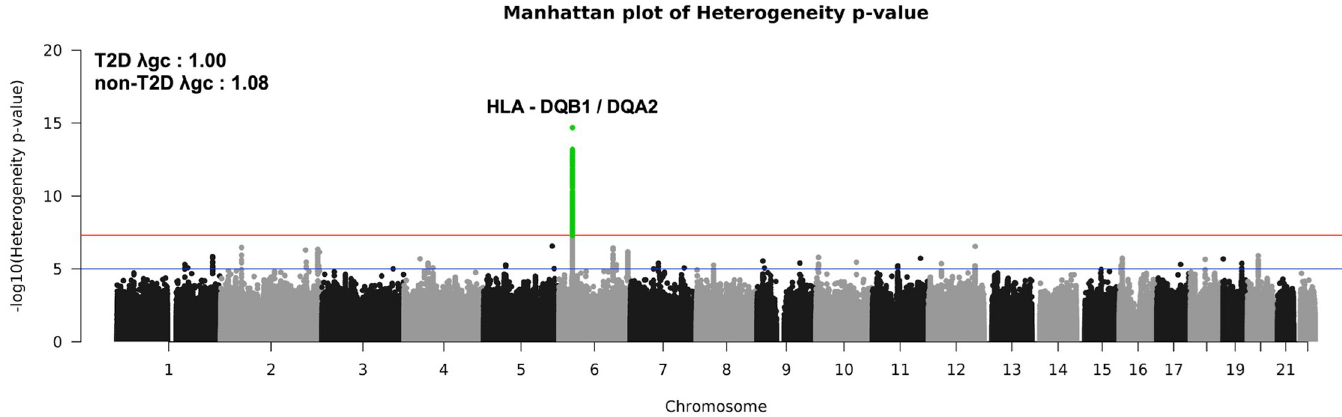
Fig 1. Genome-wide heterogeneity between T2D strata. Manhattan plot for heterogeneity p-values comparing T2D and non-T2D groups. Only one locus achieved genome-wide significance and the corresponding variants are colored in green. Lambda GC values from GWAS stratified by T2D status is shown in the figure. Red line: Genome-wide significance (p-value = 5x10 -8 ), Blue line: Suggestive significance (p-value = 1x10 -5 ). GWAS–Genome wide association studies; T2D –Type 2